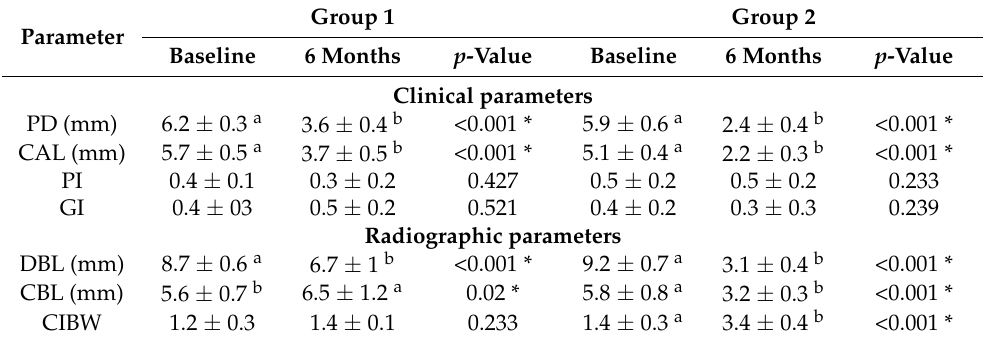
Table 2. Mean comparison of clinical and radiographic periodontal parameters between baseline and follow-up measurement at six